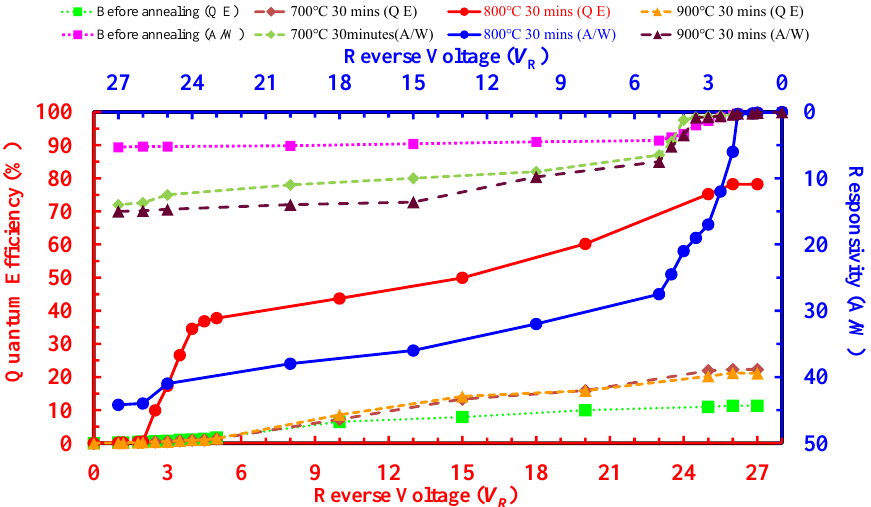
Fig. 6 Figure 6. The variation of the responsivity ( R resp , top-right axes) and quantum efficiency ( η QE , Y. -T. Cheng et . al . bottom-left axes) with the 3- µ W/cm 2 incident light at reverse bias up to 27 V. The APS devices were prepared with as-deposited and annealed poly-Si 0.8 Ge 0.2 films at 700 ◦ C, 800 ◦ C, and 900 ◦ C for 30